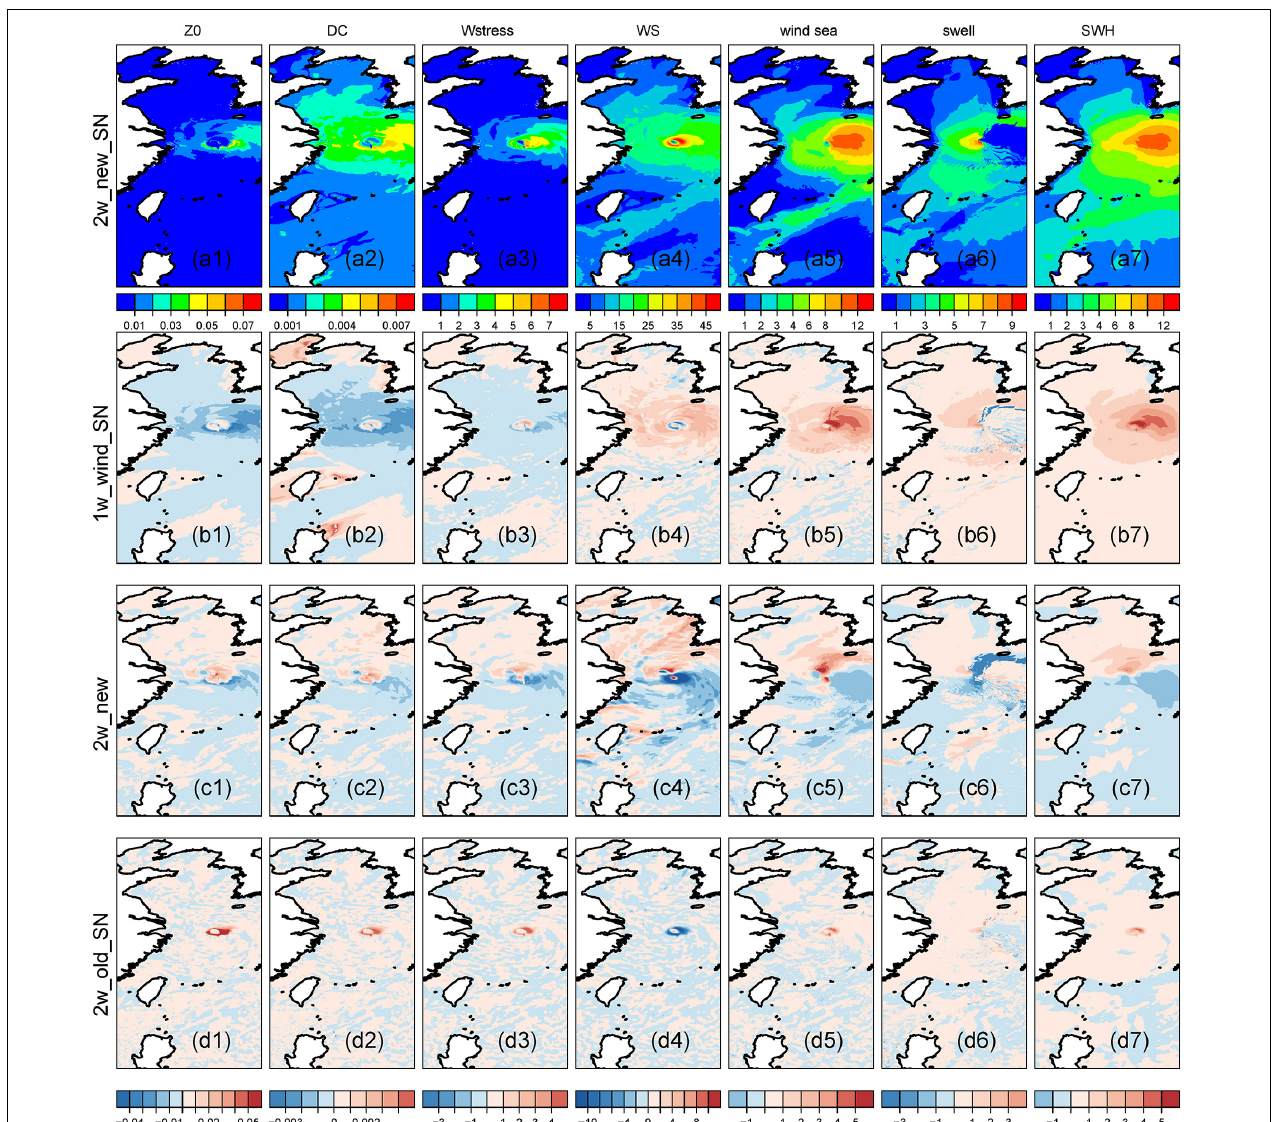
FIGURE 13 | Impact of different simulation setups on sea surface roughness length (Z0, unit: m), drag coefficient (DC), wind stress (Wstress, unit: N/m 2 ), wind speed (WS, unit: m/s), wind sea (unit: m), swell (unit: m) and significant wave height (SWH, unit: m) at 0900 UTC 6 September 2019: (a1-a7) simulation 2w_new_SN; (b1-b7) the differences between 1w_wind_SN and 2w_new_SN; (c1-c7) the differences between 2w_new and 2w_new_SN; (d1-d7) the differences between 2w_old_SN and 2w_new_SN.